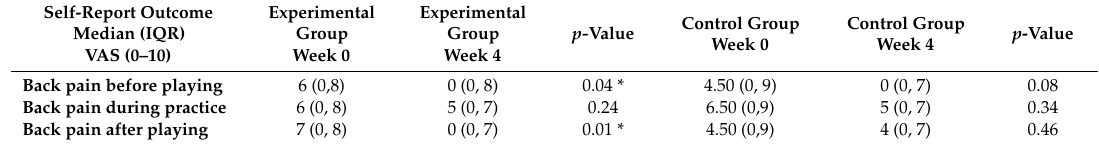
Figure 8. Progression of back pain before, during, and after playing the instrument in the EG (experimental group: Pilates method combined with therapeutic exercise) and CG (control group: therapeutic exercise) in the basal situation (week 0) and after treatment (week 4). VAS: visual analog scale (score: 0–10); *: statistically significant di ff erences ( p < 0.05) between week 0-week 4. Table 3. Results of back pain in the experimental and control groups.